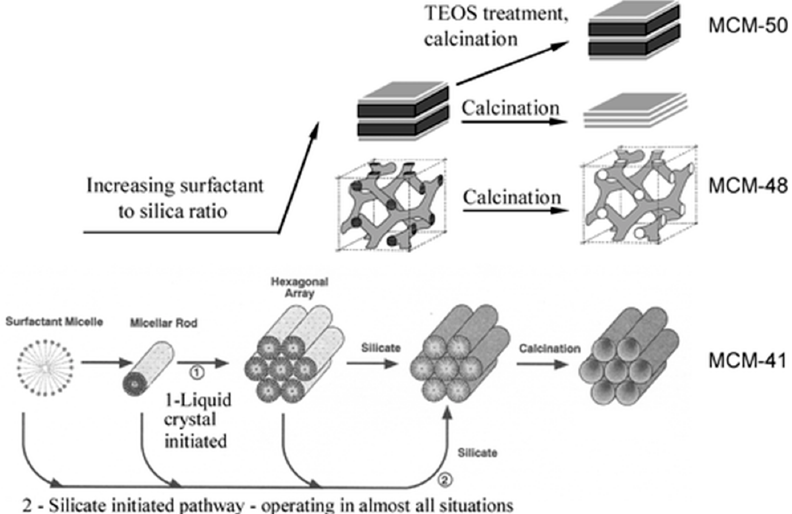
Figure 6. The proposed LCT pathways (lower half) and its other structures by increasing surfactant to silica ratio (upper half) [70]. Reprinted with permission from [70].